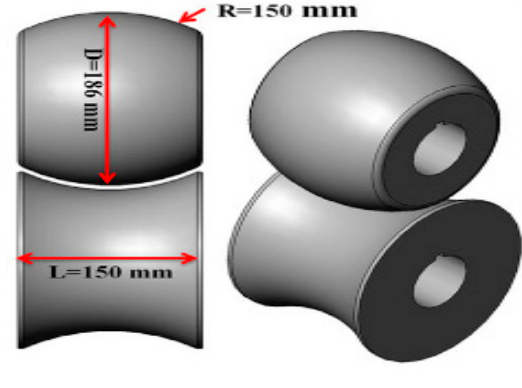
Table 4. Roll forming parameters of arc-section.